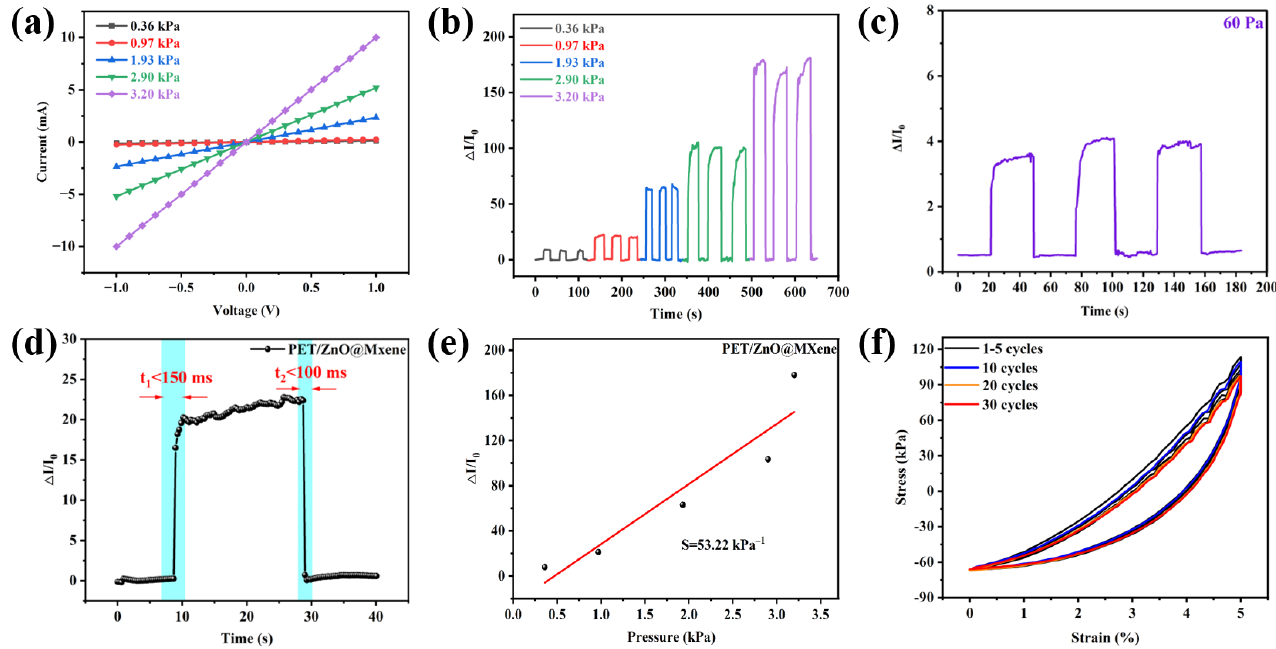
Figure 4. Electronic and sensing performance of a PET/ZnO@MXene flexible composite fabric pres- sure sensor. ( a ) I-V curve, ( b ) I-T curve under different applied pressures, ( c ) response change under P = 60 Pa pressure, ( d ) response recovery time under P = 0.97 kPa pressure, ( e ) linear sensitivity fitting diagram within the pressure ranges of 0.36 – 3.20 kPa, ( f ) strain – stress curve after 30 cycles under the strain of 5%.